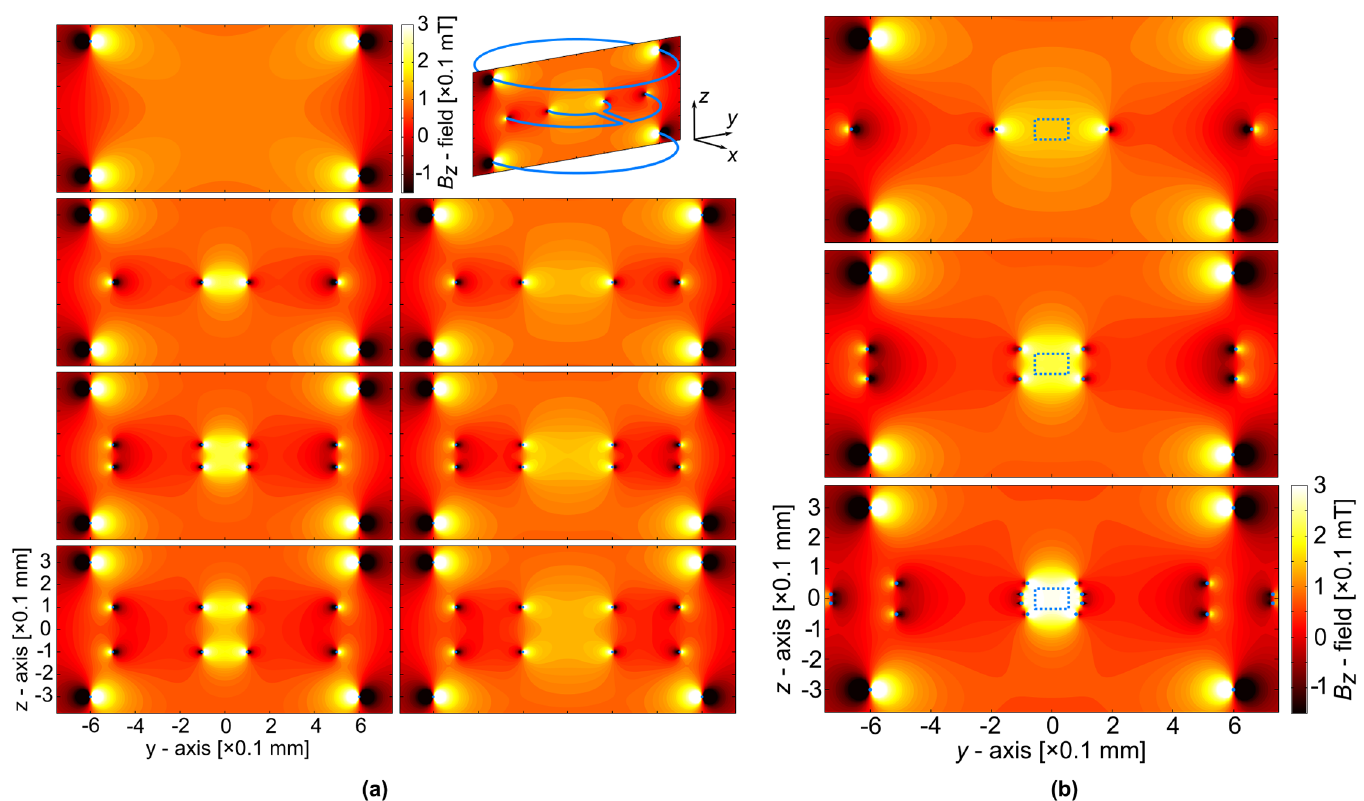
Fig 2. Simulated distribution of the z -component, B z , of the B 1 magnetic flux density for different geometrical arrangements and optimisation of the magnetic field’s homogeneity. Note that the B 0 -field is orientedparallelto the planes of the coil pair and the lenses (e.g. along the x or y -axis). (a) The B z -field inducedby a Helmholtzpair and a variety of different lenses: i.e. none, one or two lenses of different inner loop size and/or axial position.The colour contour plots are all plotted on the yz -planeas depictedin the illustrative exampleat the upper right of the figure. (b) Three optimisedsystems consisting of a Helmholtzpair and either one, two or four lenses. The size and positionof the lens elementshave been optimisedto maximise the amplification within a cylindricalvolume, depicted in the yz -planeby the blue dashed rectangle, whilst constraining the averagefield error to be 1% within this regionof interest. The examplewith four lenses exhibits a threefold amplification of field sensitivity.